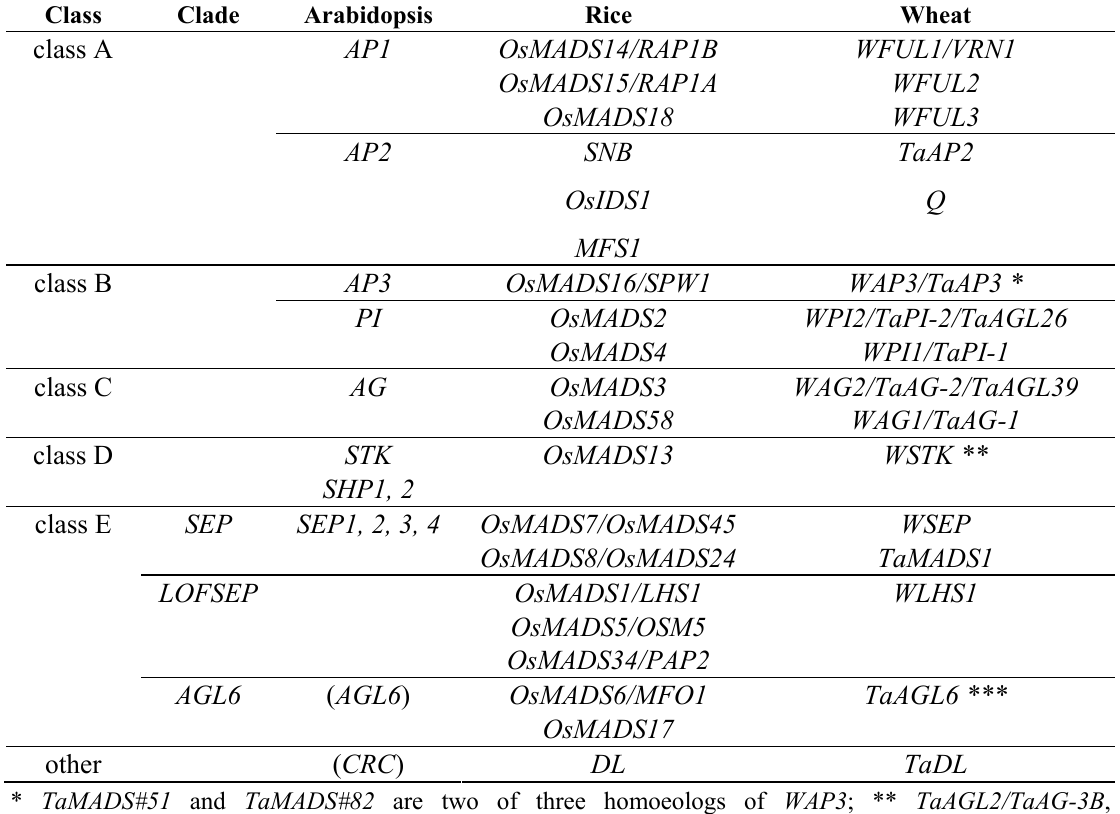
Table 1. The relationships of homeotic genes among Arabidopsis , rice and